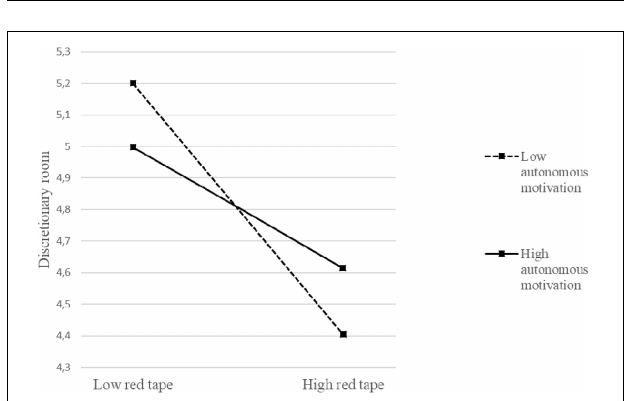
FIGURE 2 | Interaction between red tape and autonomous motivation in predicting job satisfaction.